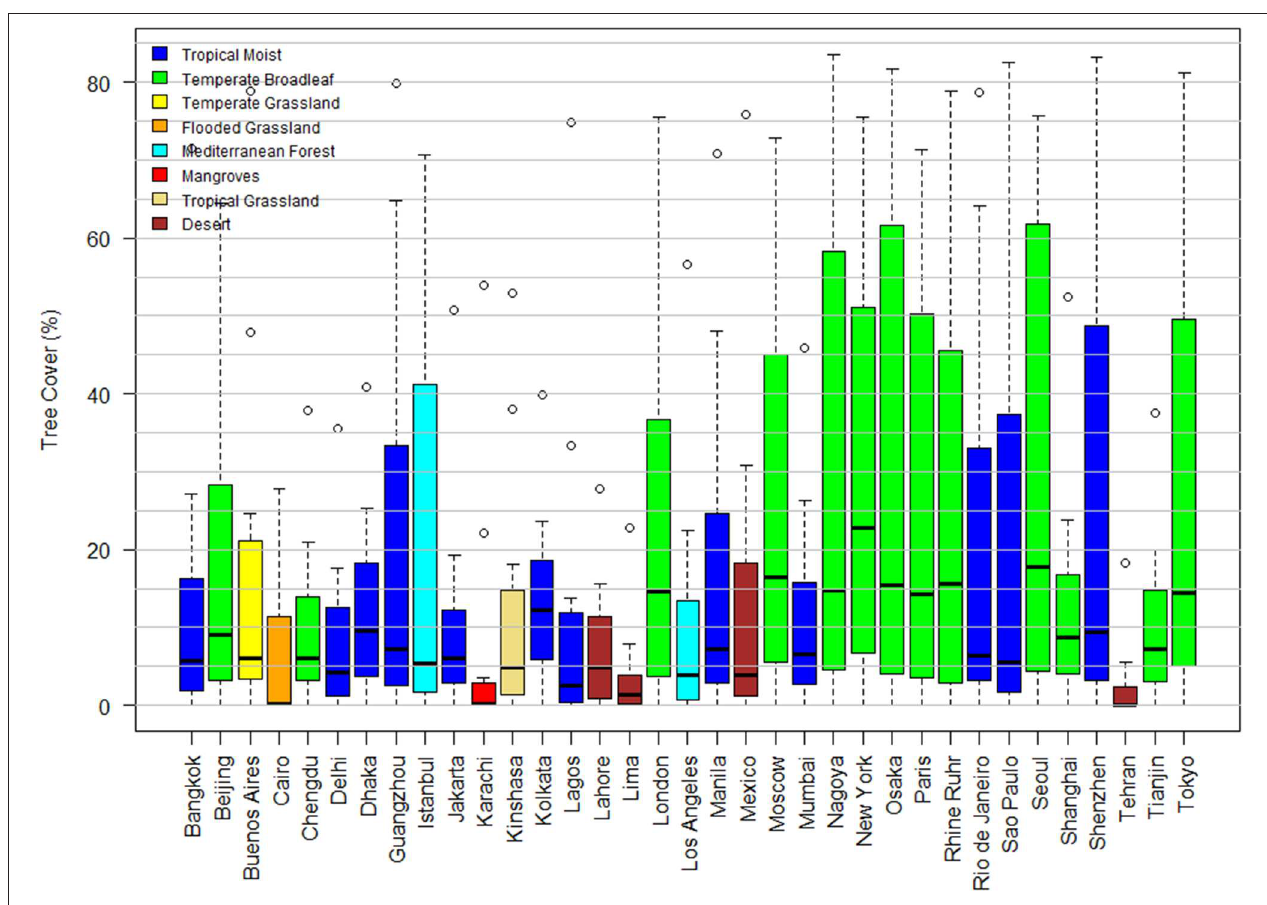
FIGURE 2 | The distribution of tree cover (%) within each of the 35 megacities, represented with box plots showing the median (50th percentile, black line), lower quartile (25th percent, bottom of box), upper quartile (75th percent, top of box), 1.5 inter-quartile range (IQR, top whisker), and maximum values greater than the IQR (open circles). The box colors represent the